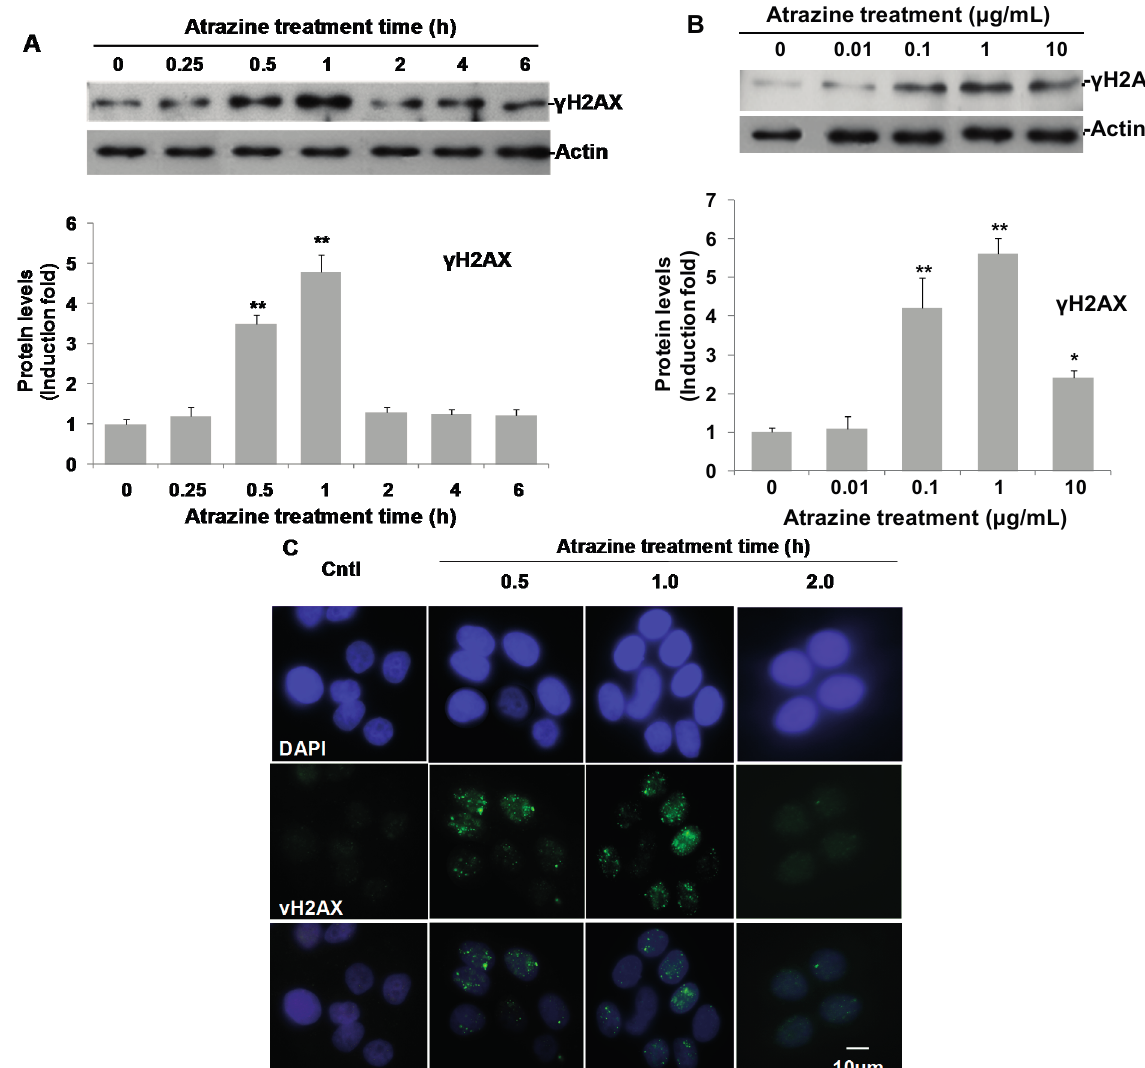
Figure 5. The induction of γ H2AX in MCF-10A cells by atrazine. ( A ) Time course of atrazine-induced γ H2AX. MCF-10A cells (3 × 10 5 ) treated with 0.1 μ g/mL atrazine for indicated hours and analyzed by Western blotting; ( B ) dose-response of atrazine-induced γ H2AX. MCF-10A cells (3 × 10 5 ) were exposed to the indicated concentrations of atrazine for 1 h and analyzed by Western blotting. For each blot, the resulting fold-change of atrazine-mediated phospho-H2AX (Ser139) expression over DMSO untreated controls is provided in the corresponding histogram ( n = 3) with the signal normalized to actin as a loading control; ( C ) The representative images showing γ H2AX foci induced by 0.1 μ g/mL of atrazine for indicated hours. Phospho-H2AX antibody was indirectly labeled with Alexa Fluor 488 secondary antibody (green), and cells were mounted with VECTASHIELD Mounting Medium with DAPI (purple). The images were captured using a Carl Zeiss confocal microscopy using the same exposure time. * p < 0.05, ** p < 0.01 vs.